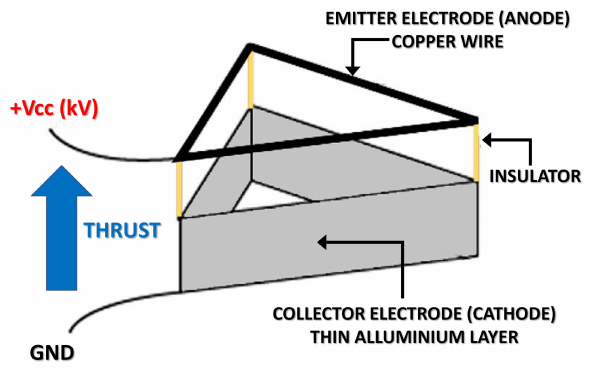
Figure 1. Asymmetrical